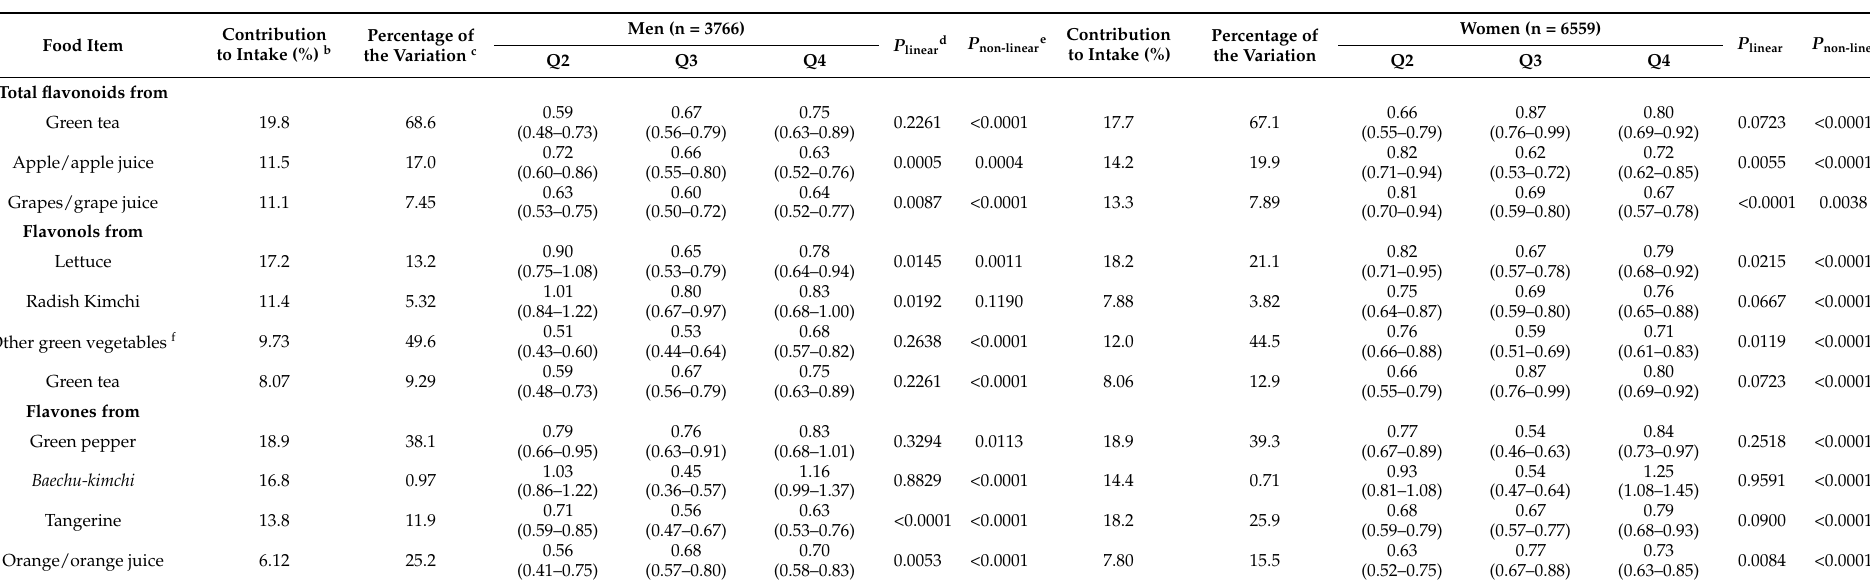
Table 3. Incident Rate Ratios (IRRs) and 95% Confidence Intervals (CIs) of hypertension by quartiles of the dietary flavonoids and its subclasses from their major food sources (n = 10,325) a